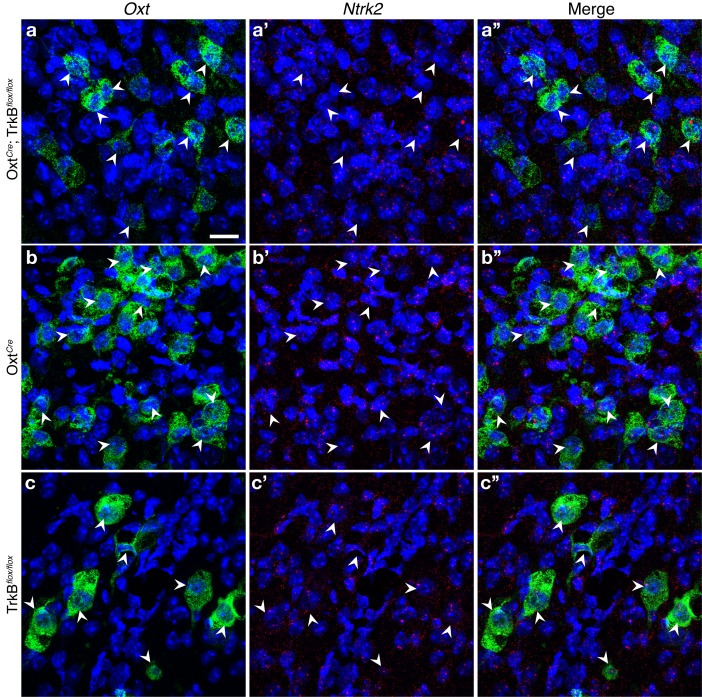
Selective loss of TrkB mRNA in OXT neurons in OxtCre; TrkBflox/flox mice.(a-c) Confocal z-projections of Oxt (a, b, c) and Ntrk2 (a’, b’, c’) transcripts in brain sections containing the PVN from OxtCre; TrkBflox/flox (a), OxtCre (b), and TrkBflox/flox (c) visualized with RNAscope in situ hybridization. In the merged images (a”, b”, c”) Ntrk2 transcripts (red) localize to the nuclei of Oxt-expressing neurons (green) in OxtCre and TrkBflox/flox mice, but not OxtCre; TrkBflox/flox mice. The Ntrk2 probe was custom-designed to specifically target the floxed region in TrkBflox/flox mice, which includes the 5’UTR and Exon S.